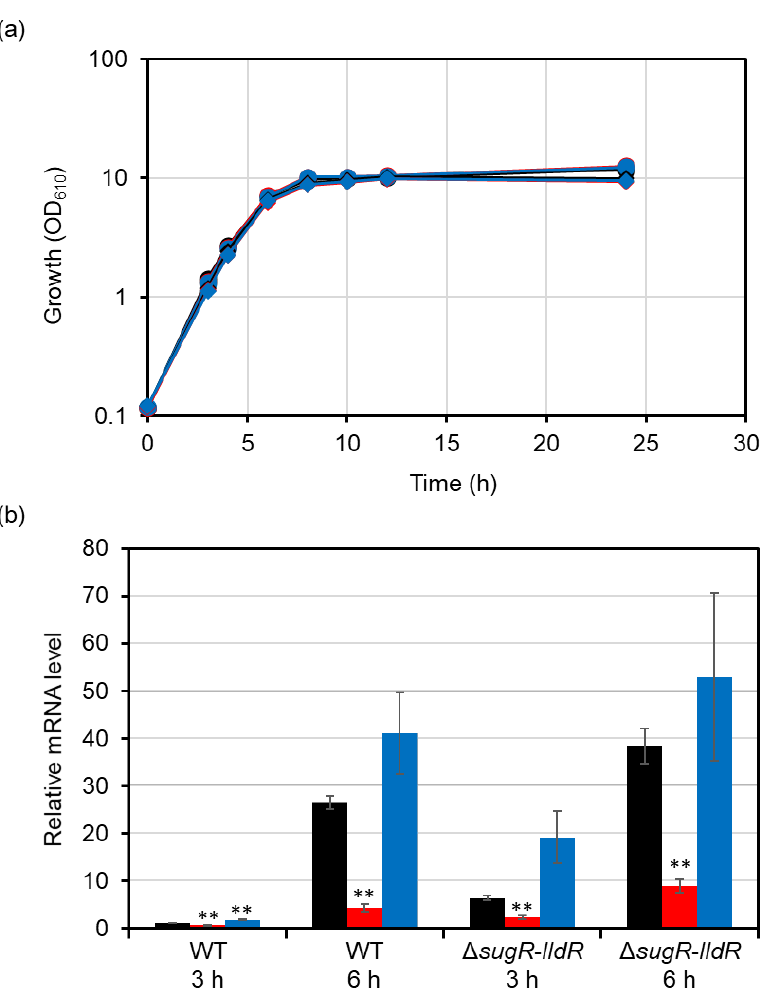
Figure 4. Effects of mutations in the GlxR-binding site on ldhA expression. ( a ) Growth of the wild type (circles) and the sugR – lldR deletion mutant (diamonds) with the native (black), mut1 (red), or mut2 (blue) GlxR-binding site in the ldhA promoter in A medium supplemented with 1% glucose. RNA was extracted from bacterial culture samples at 3 h and 6 h. ( b ) Transcript levels of the ldhA gene in the wild type and the sugR – lldR deletion mutant with the native (black), mut1 (red), or mut2 (blue) GlxR-binding site in the ldhA promoter were determined by quantitative reverse-transcription polymerase chain reaction analysis. The transcript level in the wild type with the native promoter at 3 h was standardized to 1. Mean values obtained from three independent cultivations are shown with their standard deviations. p -values were calculated using an unpaired t -test (**) p < 0.01.